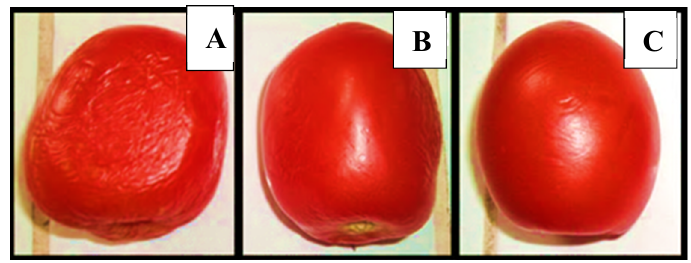
Figure 4. Visual aspect of tomatoes on the tenth day of storage (25 °C). ( A ) Uncoated tomato samples (Control), ( B ) coated samples, ( C ) coated samples with F. cernua extract.